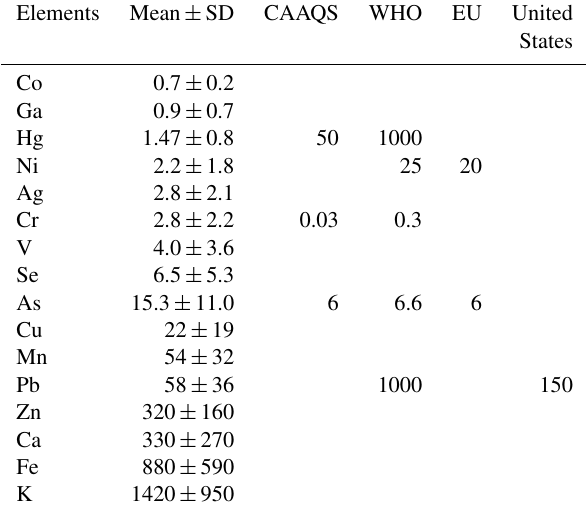
Table 1. Comparison of the element concentrations in PM 2 . 5 of Tangshan and the standard values for these elements in World Health Organization (WHO), China, Europe, and the United States (unit – ngm − 3